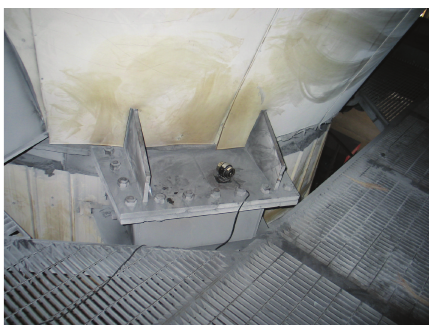
Figure 9: The sensor shown in close-up.